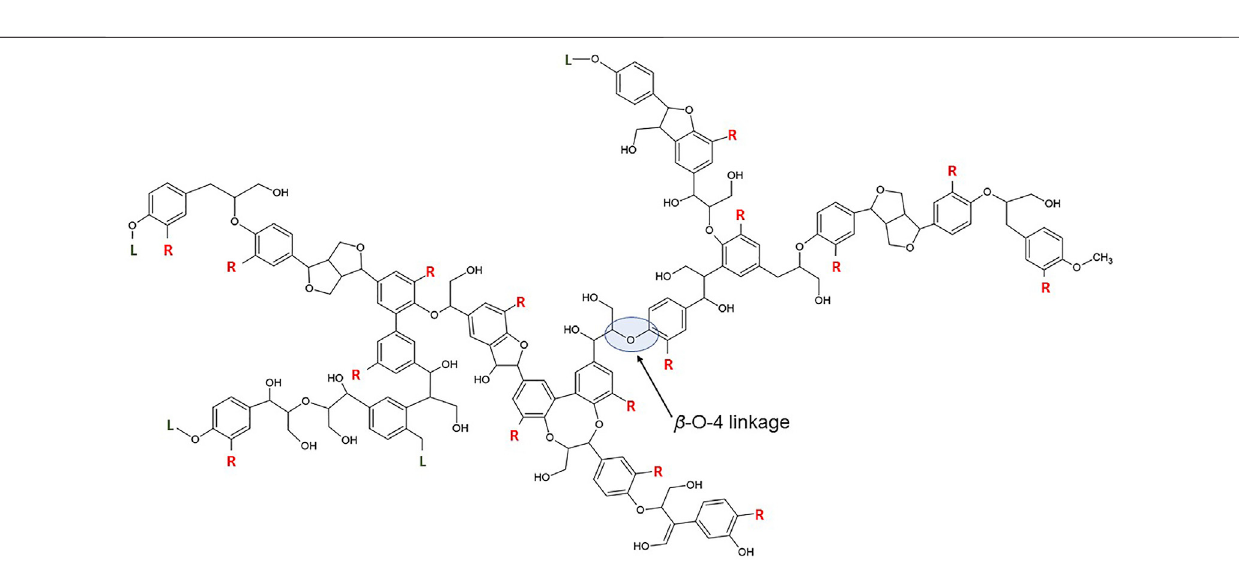
Frontiers in Energy Research |